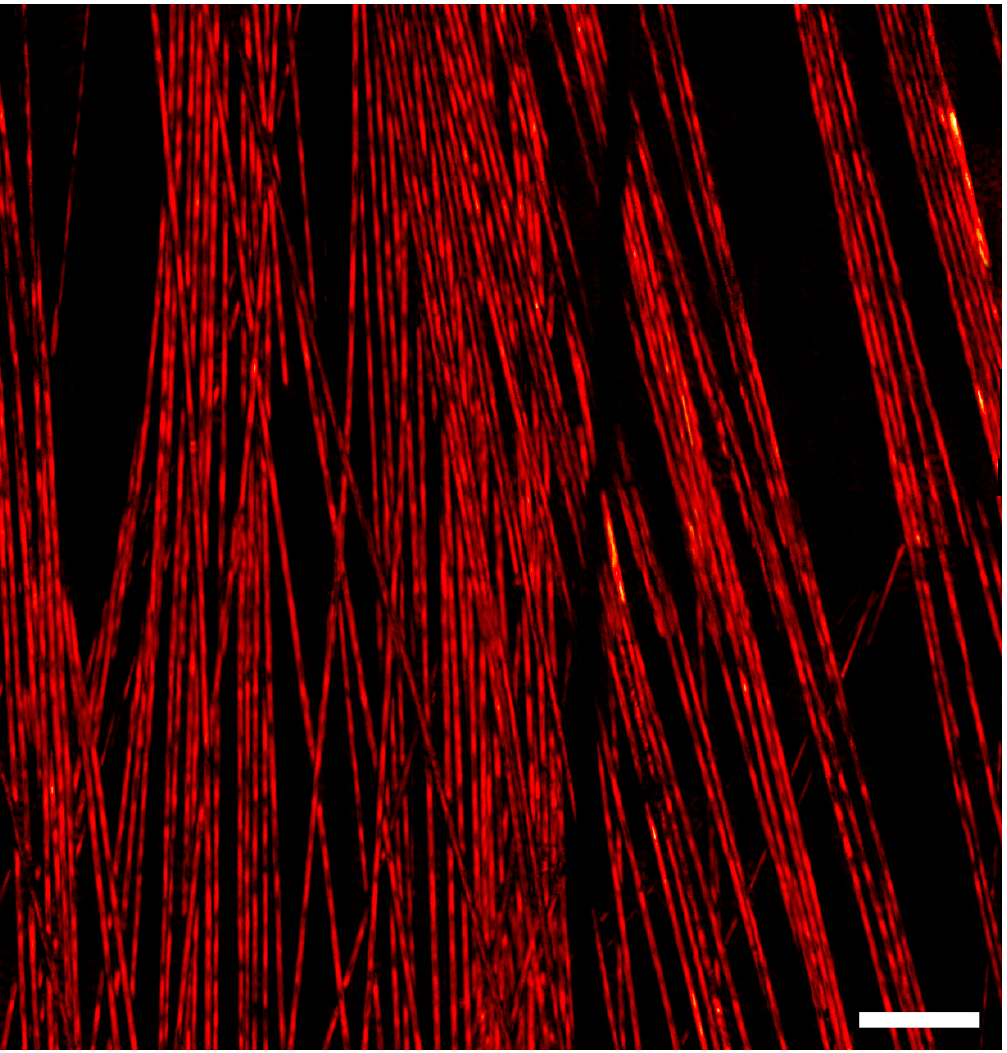
Figure 3. A 100-frame mosaic, arranged in a 10 × 10 grid. Each frame is 125 × 125 µm 2 , whereas the total field of view is approximately 0.8 × 0.8 mm 2 . The image was acquired with a 532 nm excitation source operating at 600 kHz. Scale bar 100 µm.